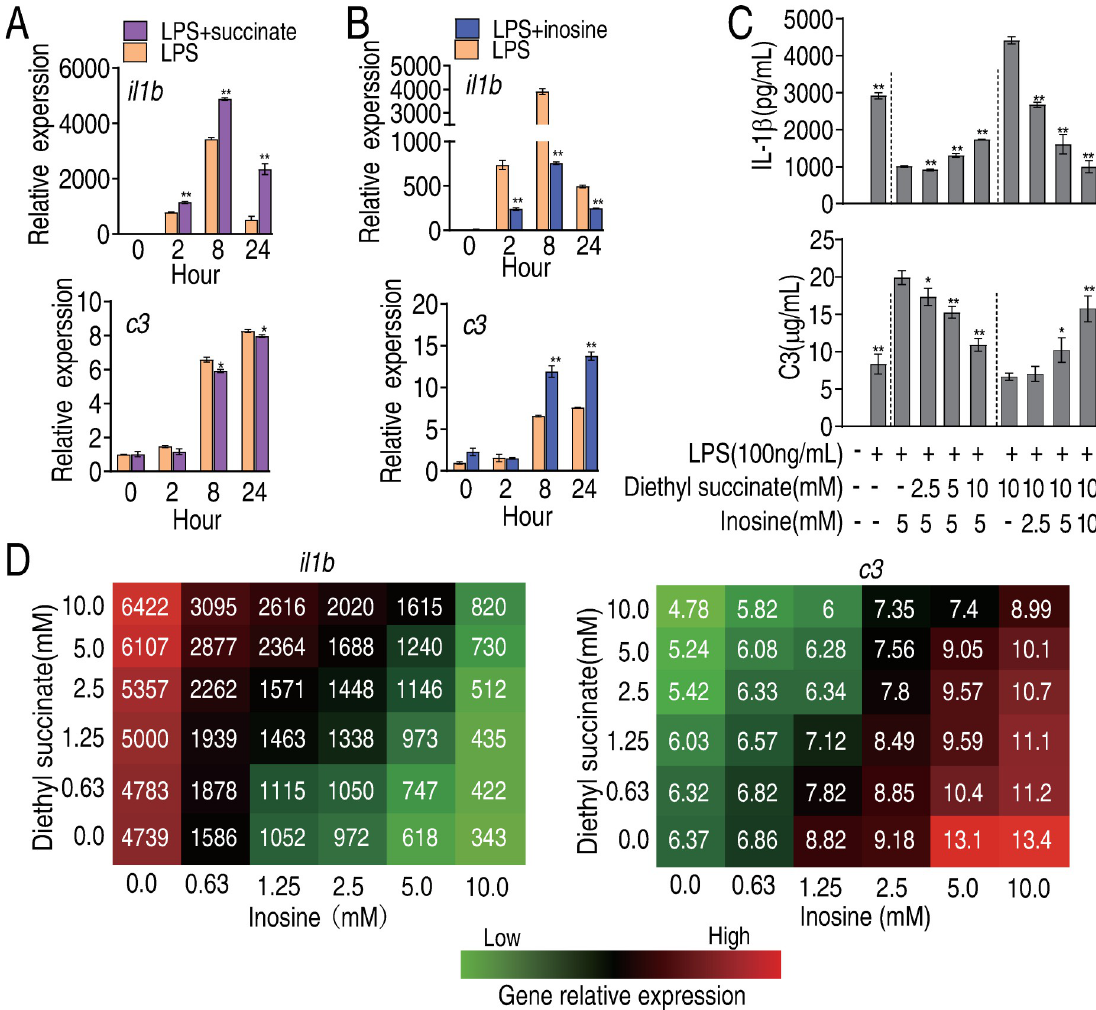
Fig 3. Comparative regulation to LPS-induced gene expression between succinate and inosine. A, Transcripts of il1b and c3 were quantified in cells treated with LPS in the presence or absence of succinate as indicated. B, Transcripts of il1b and c3 were quantified in cells treated with LPS in the presence or absence of inosine as indicated. C, Abundance of secreted IL-1 β and C3 in cells treated with LPS, dimethyl succinate, inosine or LPS plus dimethyl succinate or LPS plus inosine or LPS plus inosine and dimethyl succinate at the indicated concentrations. D, Isobolograms showing antagonistic effects of inosine and succinate on expression of il1b and c3 . Results (A-C) are displayed as mean ± SEM, and significant differences are identified ( � P < 0.05, �� P < 0.01) as determined by non-parametric Mann- Whitney U test (A and B) and non-parametric Kruskal-Wallis one-way analysis with Dunn multiple comparison post hoc test (C).